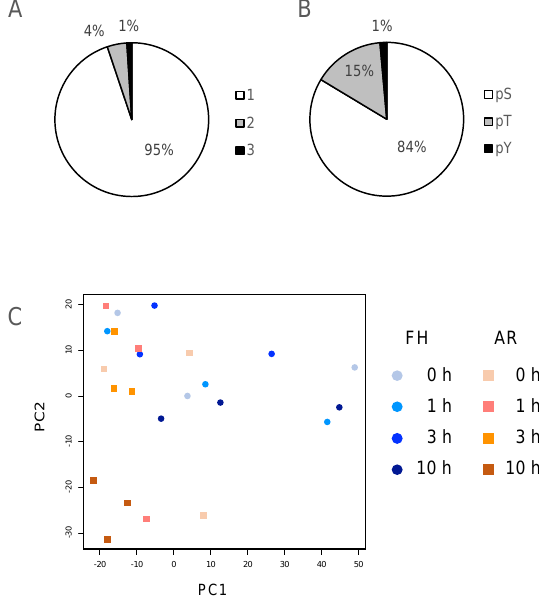
Figure 1. Summary of phosphoproteomic data. ( A ) Frequency of phosphorylated residues distributed in the phosphopeptides. Each number indicates the number of phosphorylation sites in phosphopeptides. ( B ) Distribution of phosphorylated residues in each phosphopeptide. pS, pT and pY showed phosphorylated serine, threonine and tyrosine, respectively. ( C ) Sample pattern recognition in principal component analysis. Blue circles and orange squares indicate FH and AR samples,